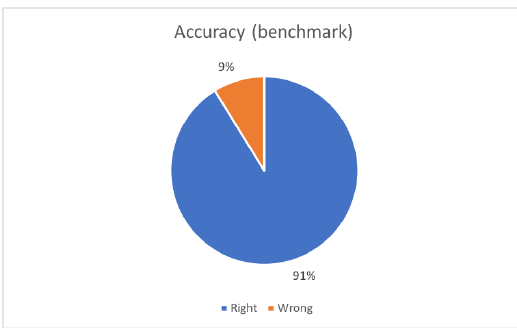
Figure 8. Precision Optimal